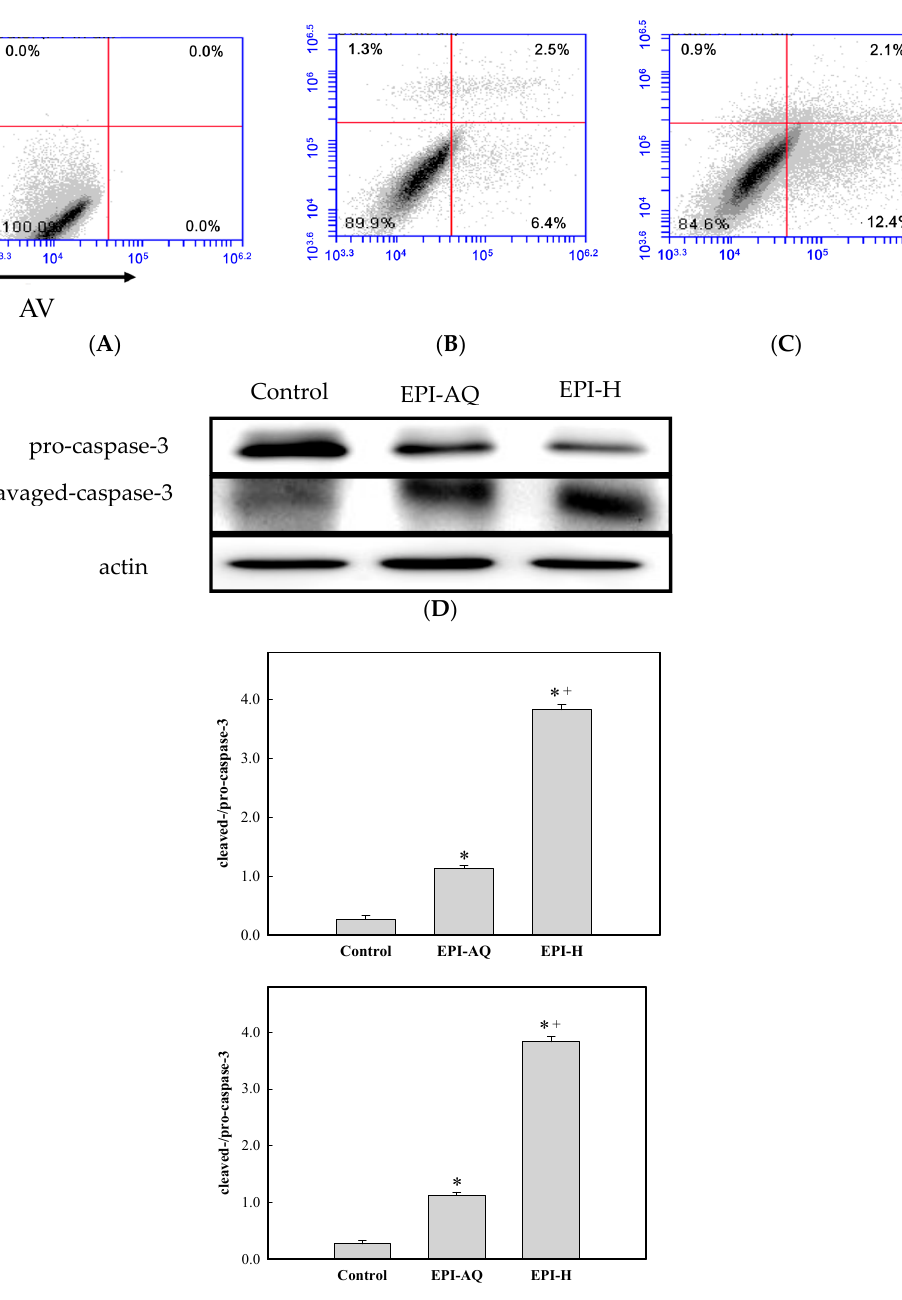
Figure 3. EPI-H enhanced apoptosis in AY-27 cells through activation of caspase 3 pathway. ( A ) AY-27 cells were treated with ( B ) EPI-AQ and ( C ) EPI-H then double-stained with Annexin V-FITC (AV) and PI followed by flow cytometry analysis. Data are presented as a percentage of the cell population; ( D ) As shown by western blot analysis EPI-AQ and EPI-H induce conversion of pro-caspase 3 to cleaved-caspase-3 in AY-27 cells. ( E ) Histogram showing the ratios of cleaved-/pro-caspase-3 in control, EPI-AQ-, and EPI-H-treated cells. Results are expressed as the mean ± SD. * p < 0.05 in cases of EPI-AQ and EPI-H vs. control. + p < 0.05 for EPI-H vs. EPI-AQ. Pro- and cleaved-caspase-3 proteins were measured by western blotting to assess apoptotic